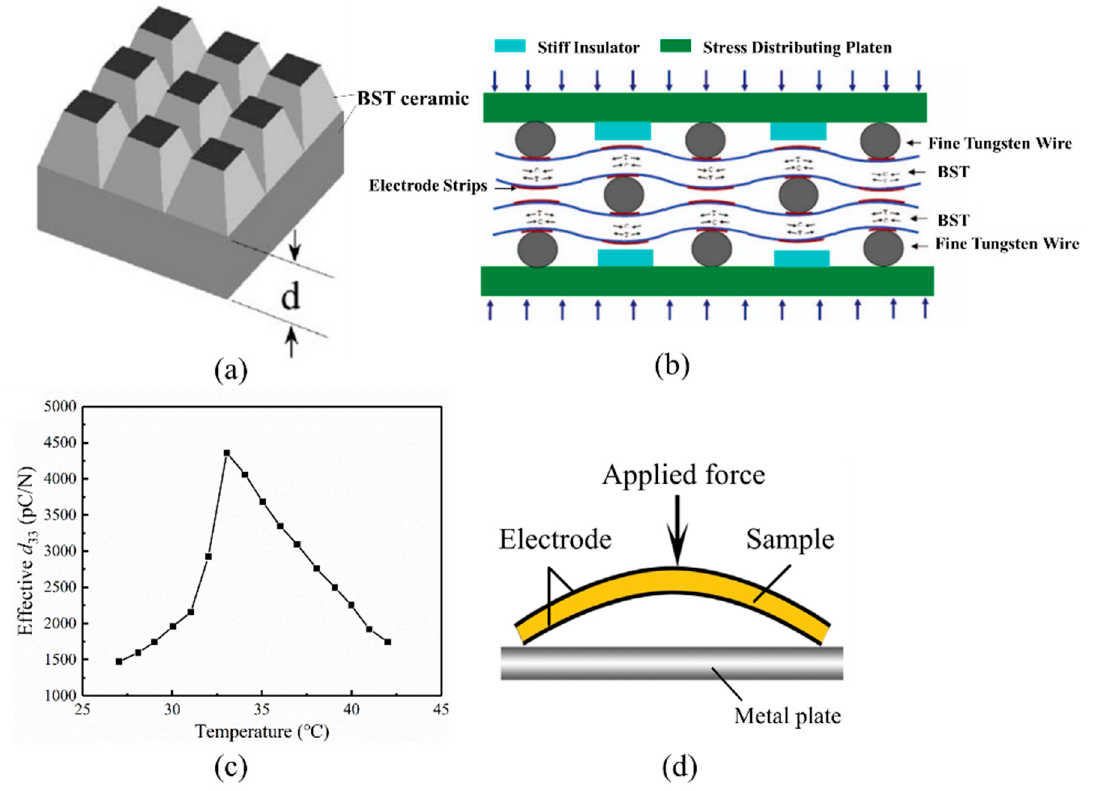
Figure 17. Schematic of ( a ) a 3 × 3 pyramid BST array structure ( d = 0.52 mm) (reprinted with permission from [111]; copyright 2006 AIP Publishing) and ( b ) a flexure mode composite. ( c ) Effective d 33 of three-layer six-unit BST composites. ( b , c ) Reprinted with permission from [37].